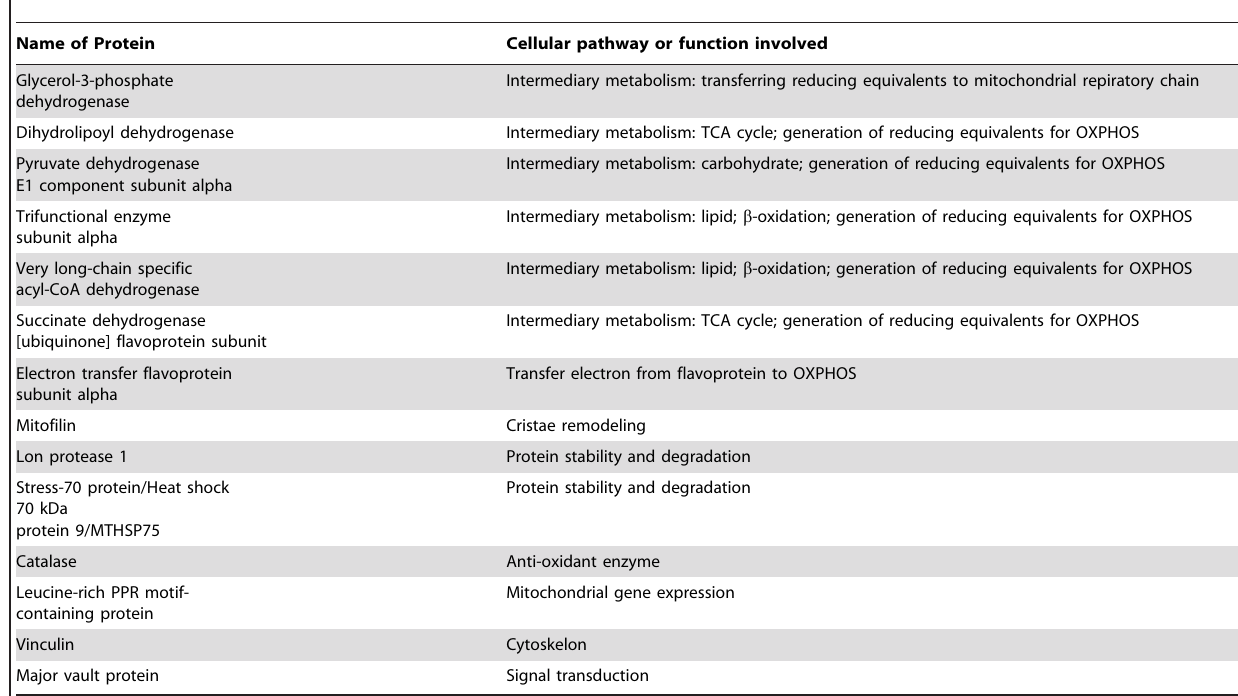
Table 6. Differentially expressed proteins which show similar trends of down-regulation in the mitochondrial proteomes of both LHON cases and unaffected relatives when compared with